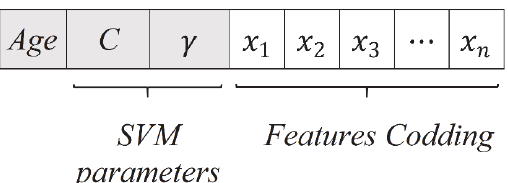
Fig. 2. Representation of a tree in the proposed